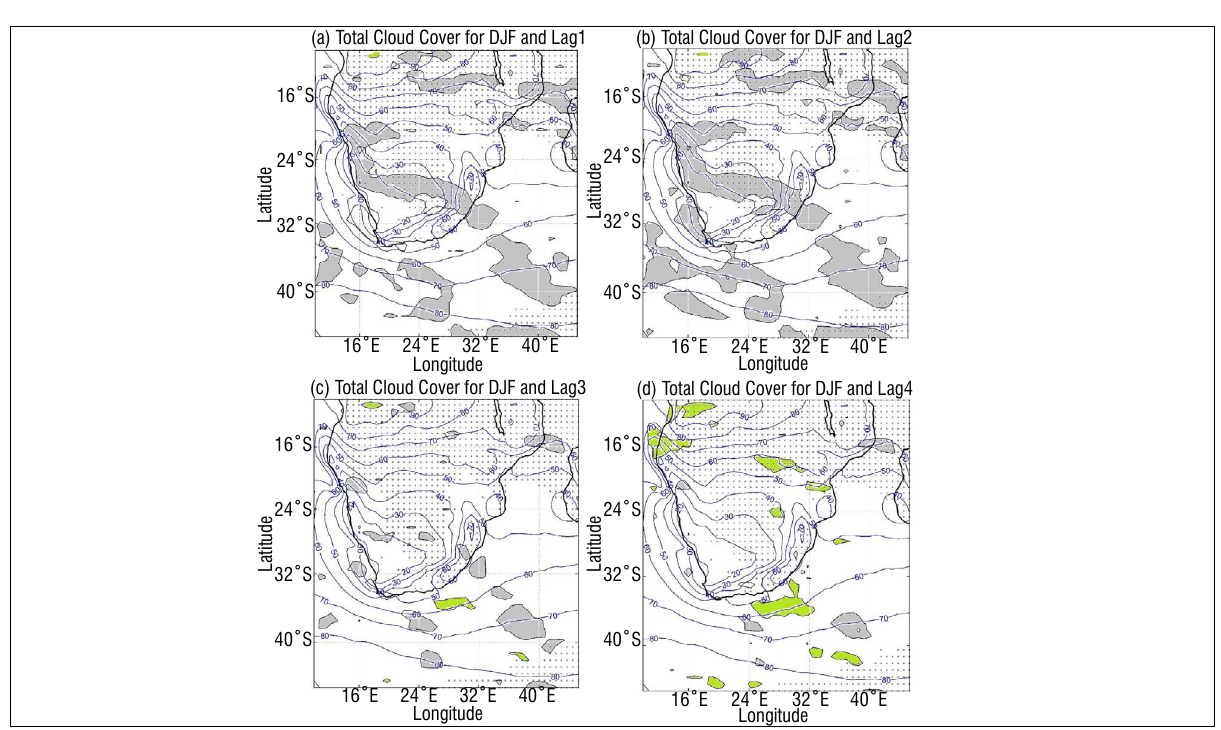
Figure 4: Total cloud cover area fraction (a–d) presented as percentage (contours) in December–February (DJF). Correlation coefficients for the Hadley cell and total cloud cover relation in DJF for (a) Lag 1, (b) Lag 2, (c) Lag 3 and (d) Lag 4. Grey shading denotes correlation coefficients greater than 0.3 and green shading indicates correlation coefficients less than -0.3. Regions of upward vertical velocity ( ω ) in Pa/s are represented by grey dots. Where there are no grey dots, there is downward motion (i.e. ω >